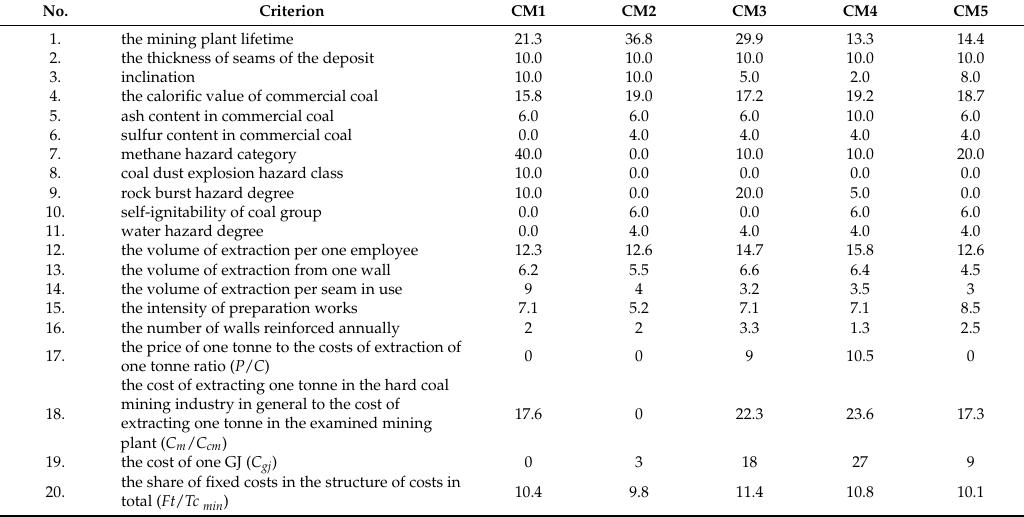
Table 6. The assessment of the given developmental criteria in the examined hard coal mines in 2016.